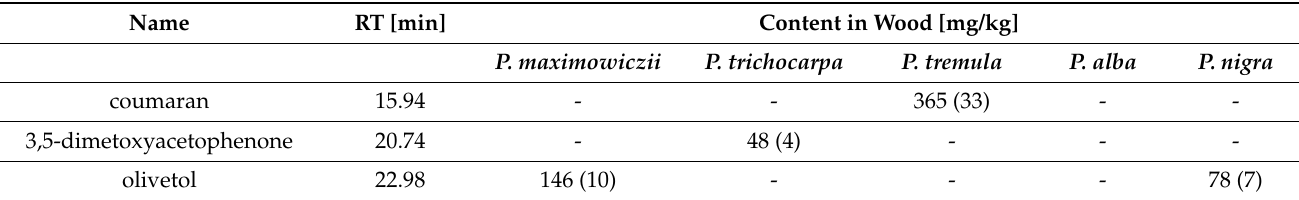
Table 4. Other compounds identified in wood extracts of the poplar species